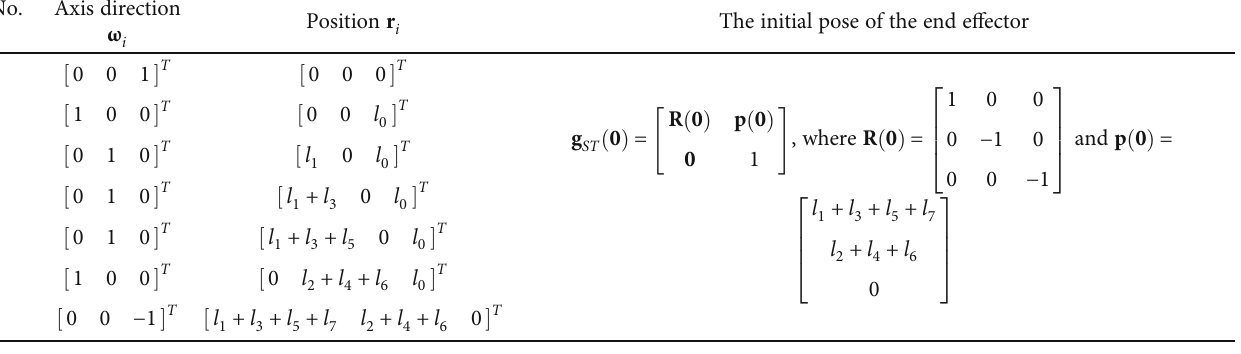
e ff ector. The pose of the tool frame f T g with respect to